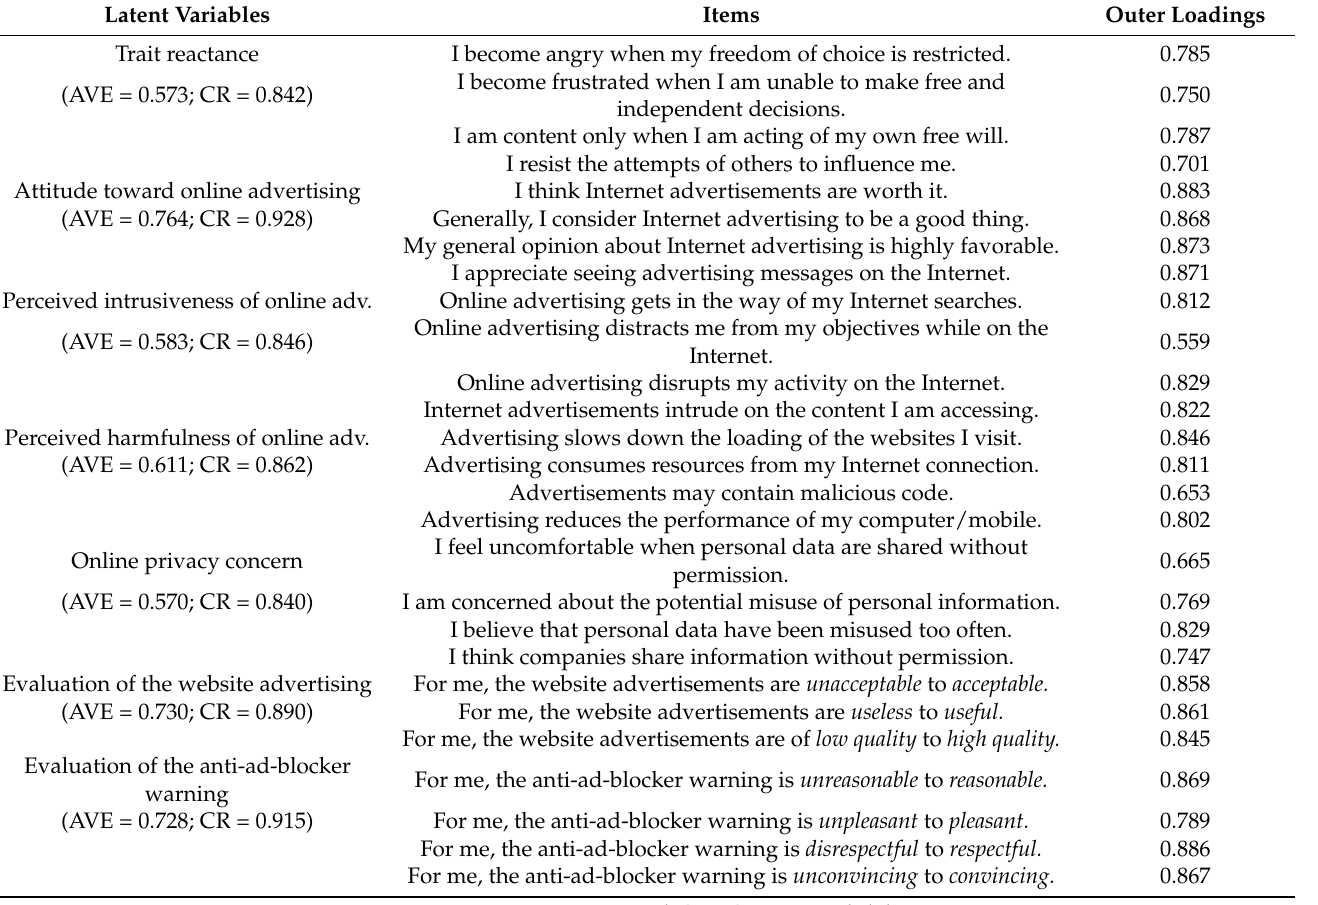
Table 1. Measurement of latent